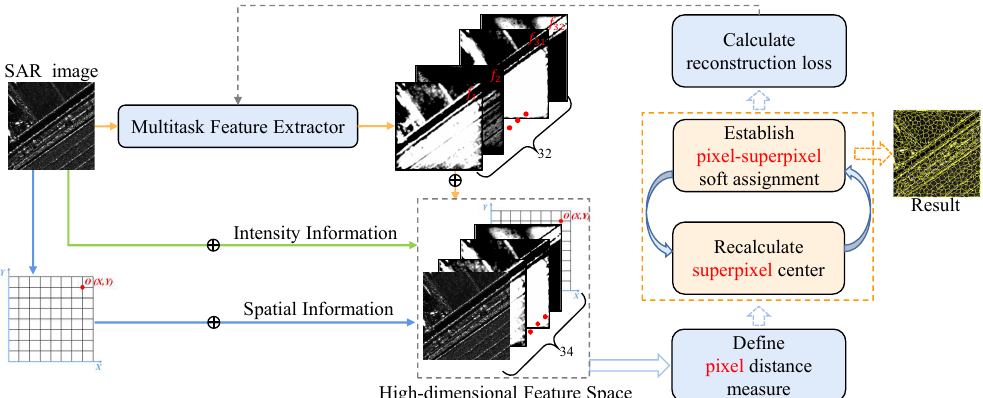
Figure 1. The architecture of the proposed classification